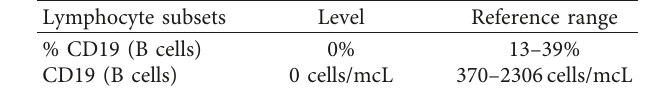
Table 2: Immune assessment B cell